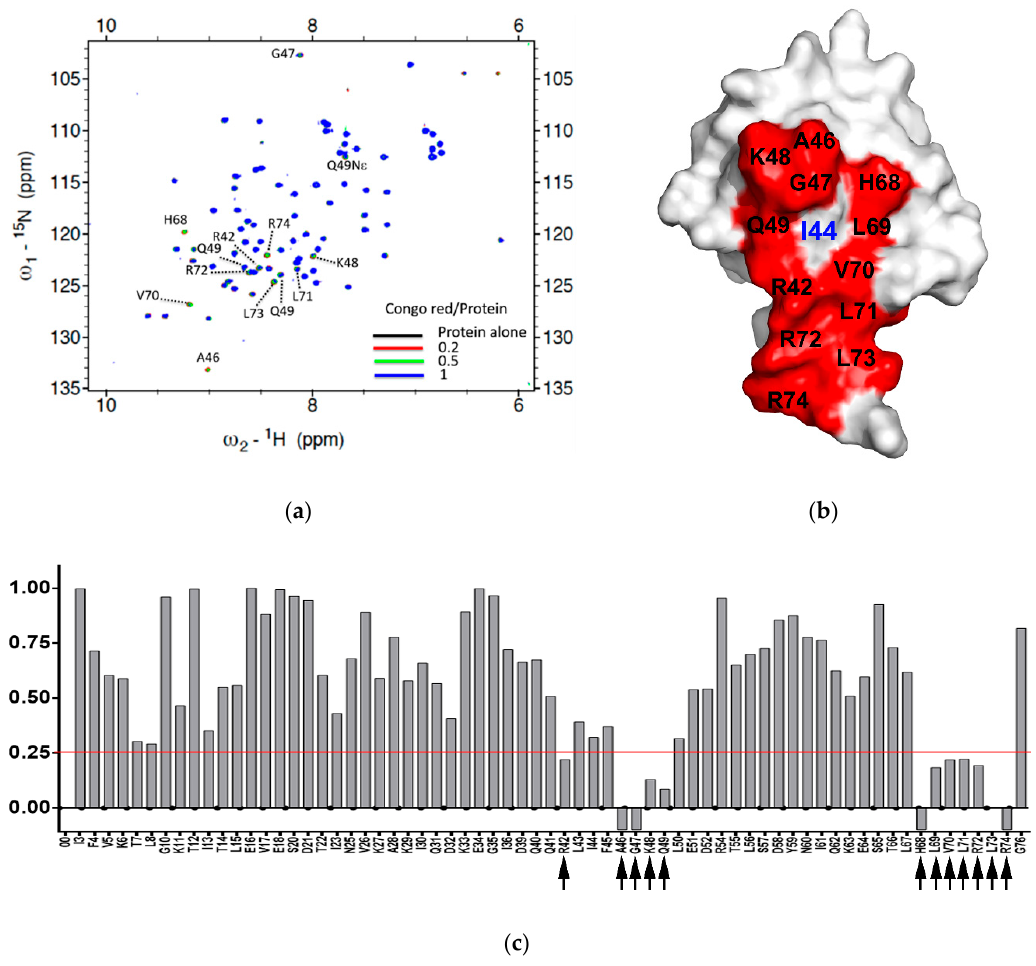
Figure 4. The interacting surface of ubiquitin used for binding with Congo red. ( a ) 1 H, 15 N-HSQC spectra of 15 N-labeled ubiquitin upon treatment of Congo red at different concentration: Black, 100 μ M 15 N-ubiquitin alone, red, with 20 μ M Congo red, green, with 50 μ M Congo red, blue, with 100 μ M Congo red. The peaks with chemical shift or line broadening are indicated by dotted lines and labeled. ( b ) The ubiquitin-interacting surface used for CR binding. The residues disturbed upon treatment with CR were indicated in red color with labels on the surface-filling model of Ub. The center of the canonical hydrophobic patched, Ile44 is labeled in blue. ( c ) Normalized intensity reduction ratio (I N ) of each residue upon treatment of Congo red (CR) at 1:1 ratio was compared. The value below zero ( − 0.1) indicates the disappearing residues. Black arrow indicates the residue whose intensity remains less than 30% (I N < 0.25, red line).